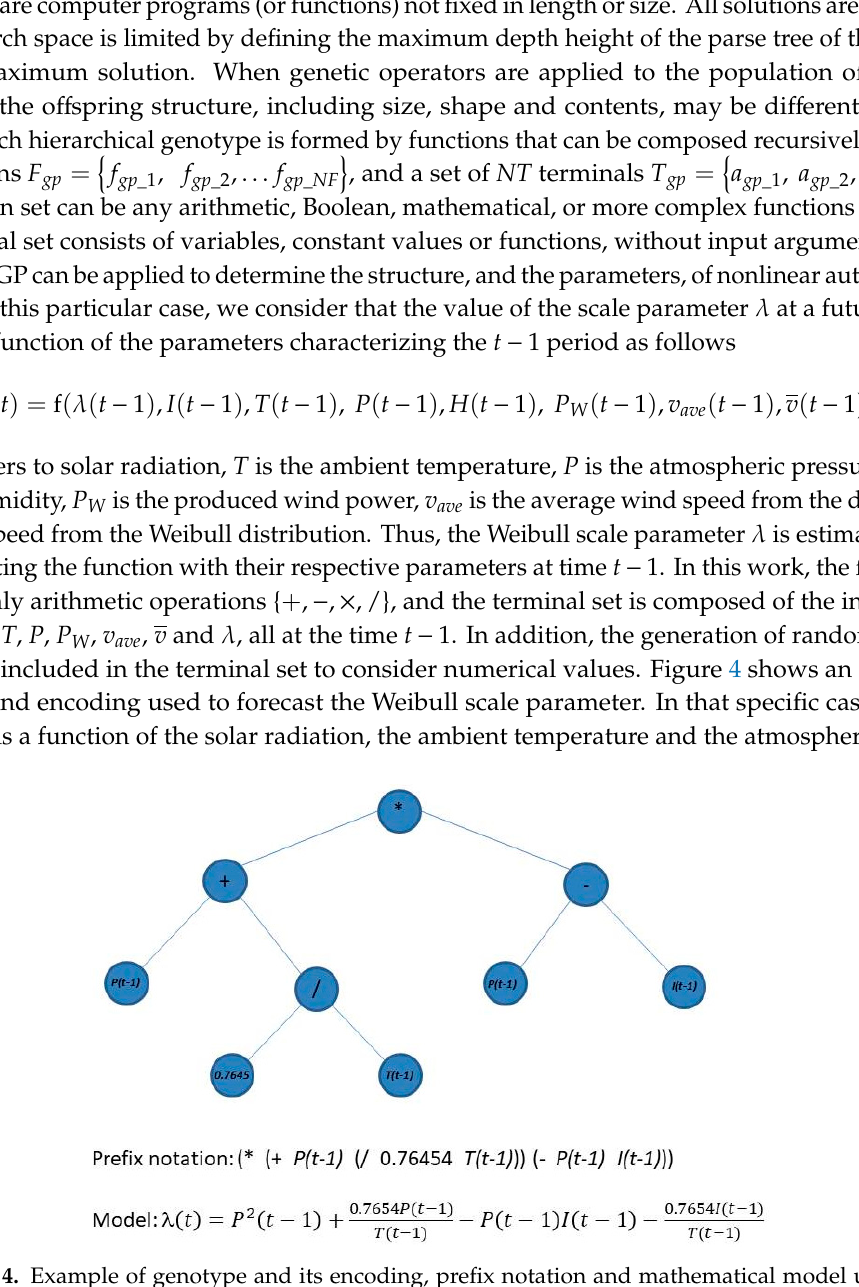
Figure 4. Example of genotype and its encoding, prefix notation and mathematical model used in the the GP.